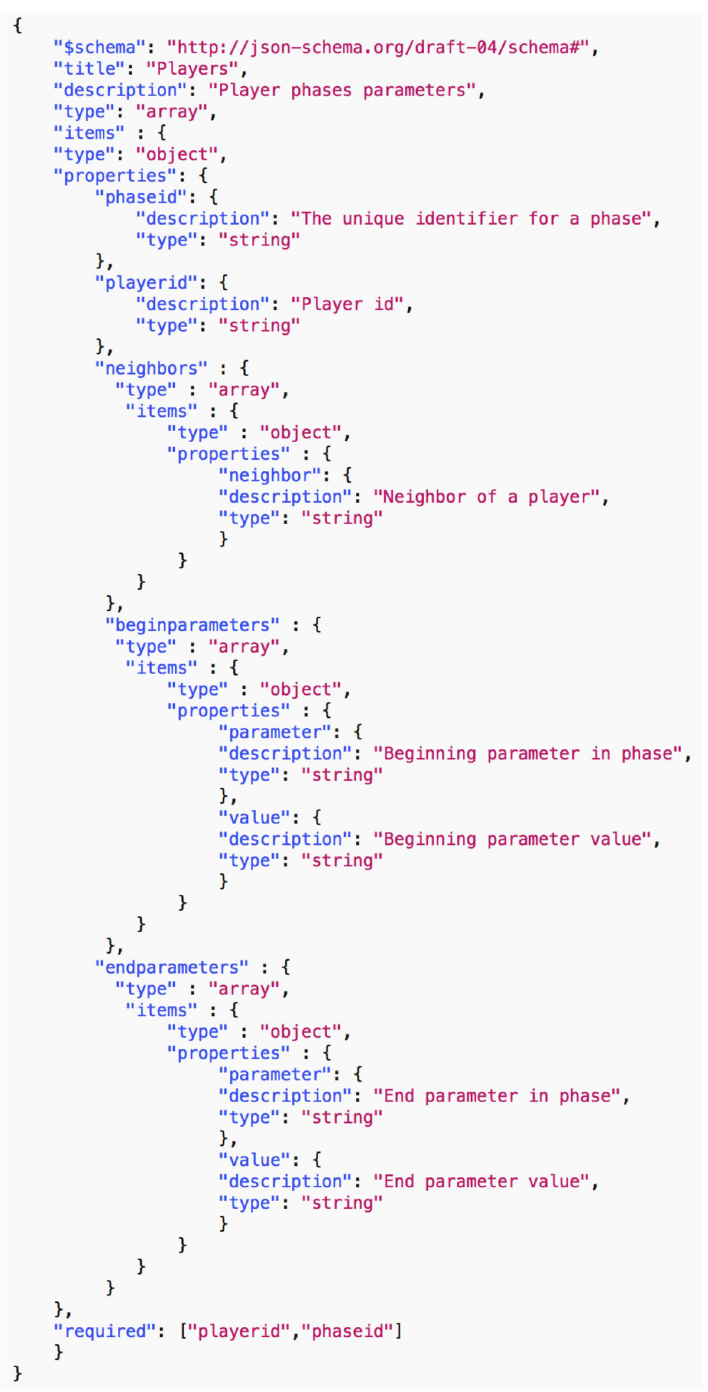
Fig 22. JSON schema for the “Player” of the data common specification.